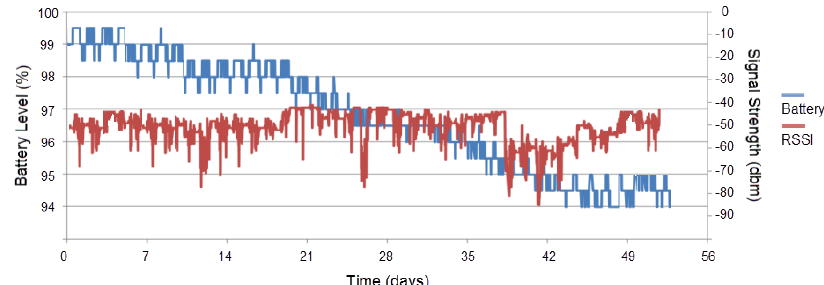
Figure 6. Battery level and signal strength readings for a period of 7.5 weeks.